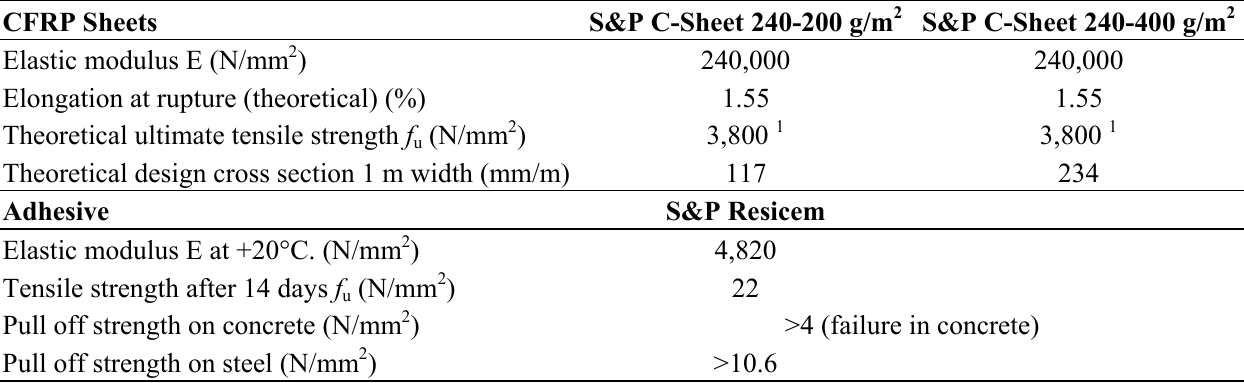
Table 2. Properties of carbon fiber reinforced polymer (CFRP) sheets (linear-elastic range) and adhesive given by manufacturer [36] based on the experiment report of